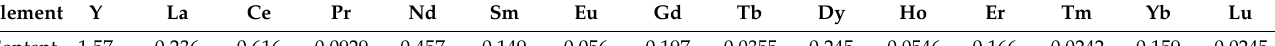
Table 1. Mass fractions of the REEs (rare earth elements, lanthanides) in chondrites for normalisation in mg/kg (ppm) [24]. Element Y